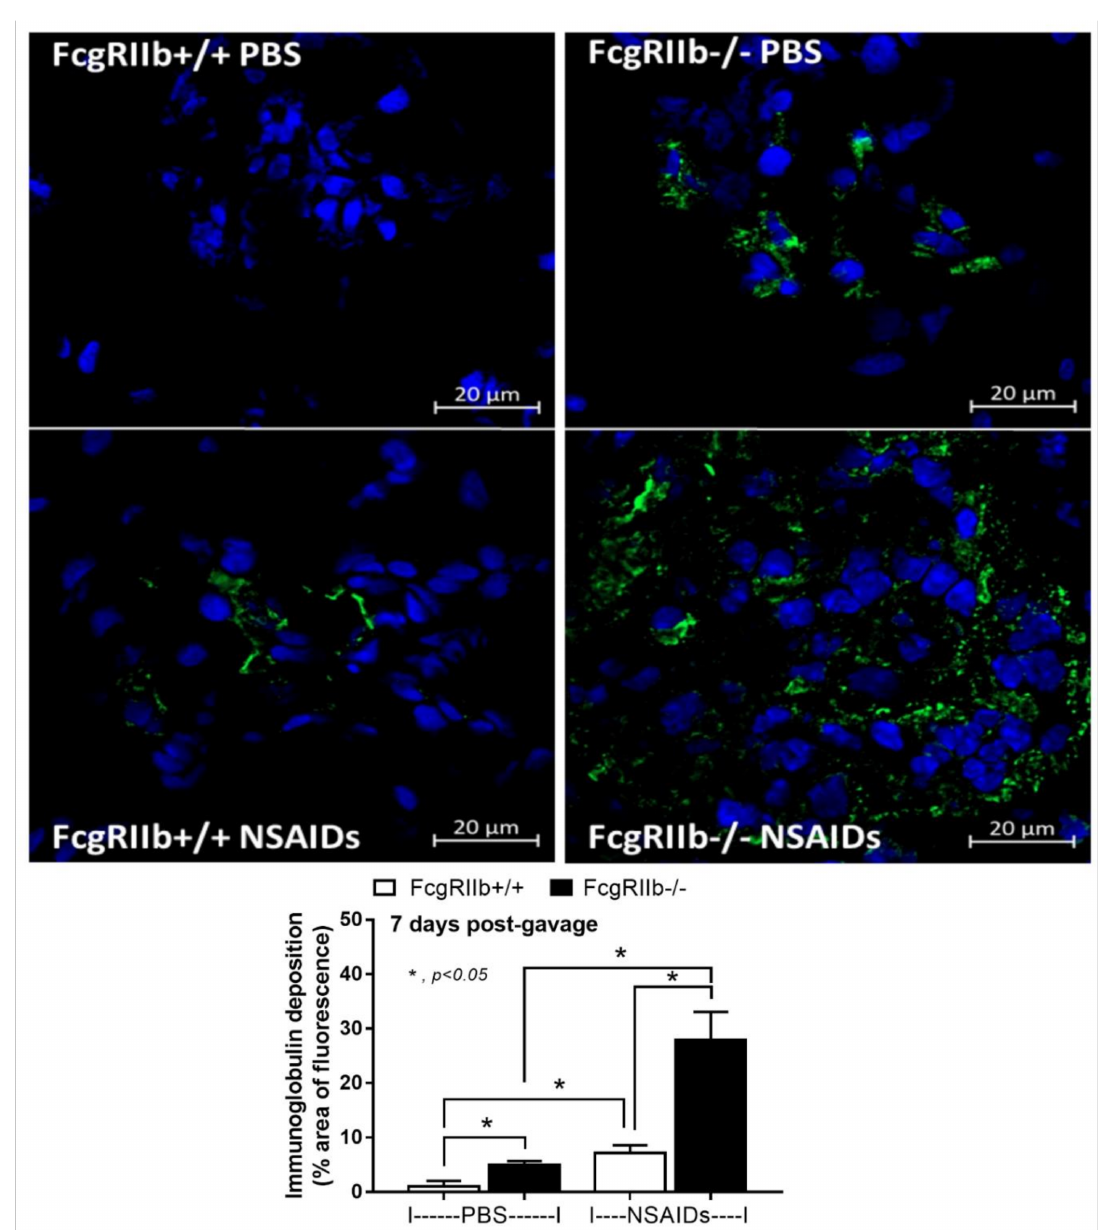
Figure 2. Representative immunohistochemistry staining (original magnification 200 × ) of immunoglobulin (green color) and cell nuclei using 4 (cid:48) ,6-diamidino-2-phenylindole (DAPI) (blue color) in glomeruli from mice with the administration of indomethacin (NSAIDs) or phosphate buffer solution (PBS) control in FcgRIIb-/- lupus mice and wild-type (FcgRIIb+/+) mice at 7 days of the administration with the immunofluorescent score ( n = 5–7/group) are